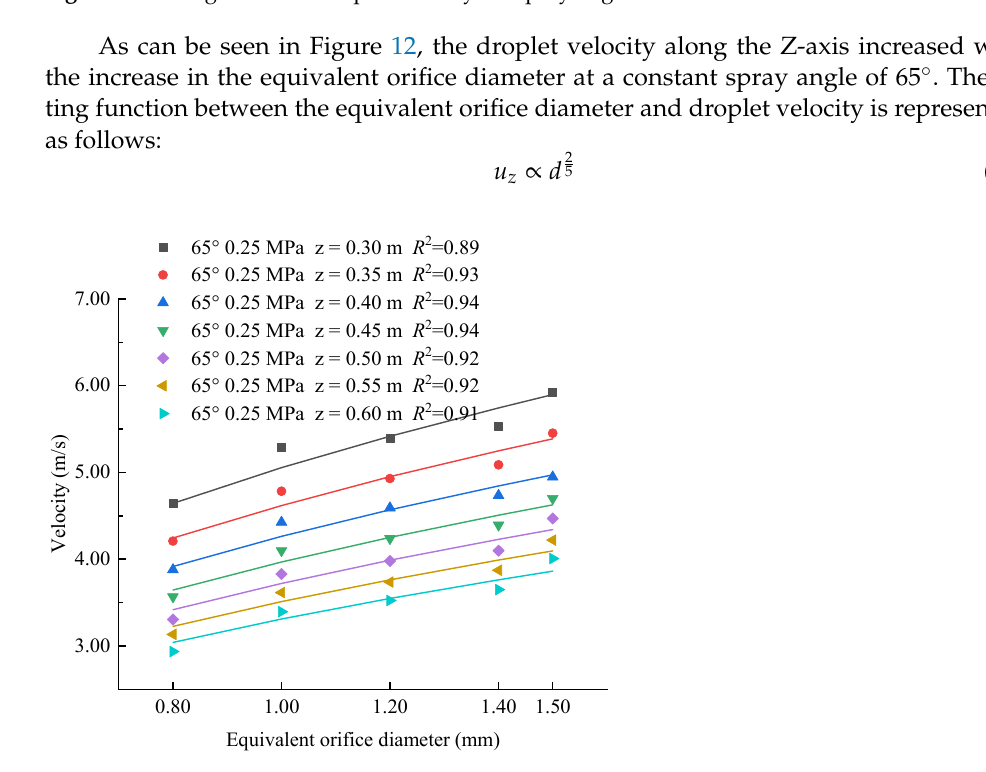
further explores the relationship between w x and the spray parameters based on the experimental